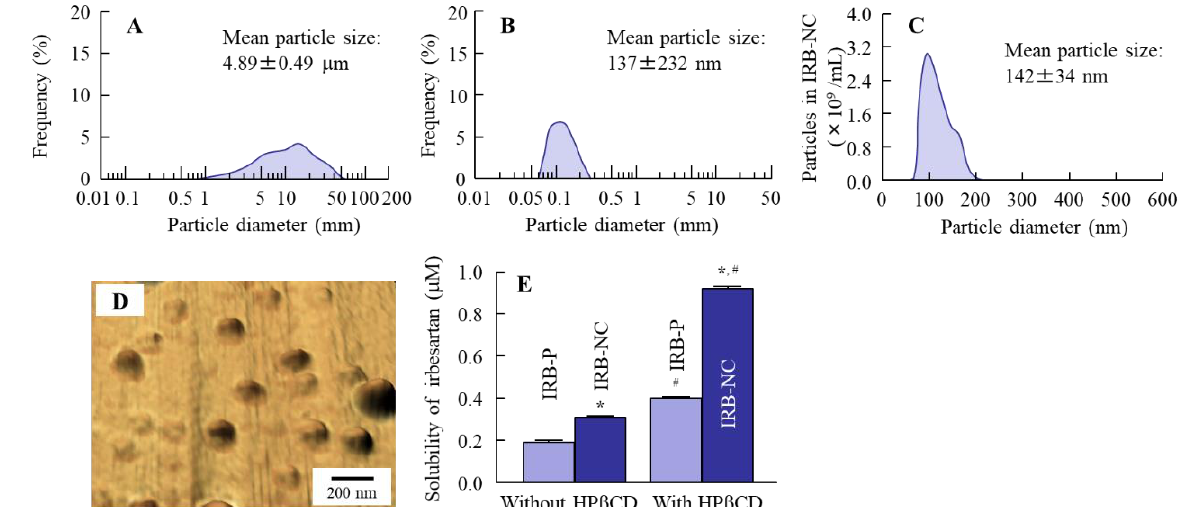
Figure 1. Particle size frequencies and solubility of irbesartan in the IRB-NC suspensions. ( A ) Particle size frequencies of irbesartan in the IRB-P suspensions. ( B , C ) Particle size frequencies of irbesartan in the IRB-NC suspensions. Data in ( A , B ) were measured using a laser diffraction particle size analyzer (SALD-7100), and those in ( C ) were obtained by the dynamic light scattering method (NANOSIGHT LM10). ( D ) AFM image of irbesartan in the IRB-NC suspensions. ( E ) Solubility of irbesartan in the IRB-NC suspensions with or without HP β CD. n = 6. * p < 0.05 vs. IRB-P for each category. # p < 0.05 vs. IRB without HP β CD for each category. The particle size of the IRB-NC suspensions was approximately 60–250 nm. The inclusion complex formation of the IRB-NC suspensions with HP β CD was higher than that of IRB-P, and the solubility